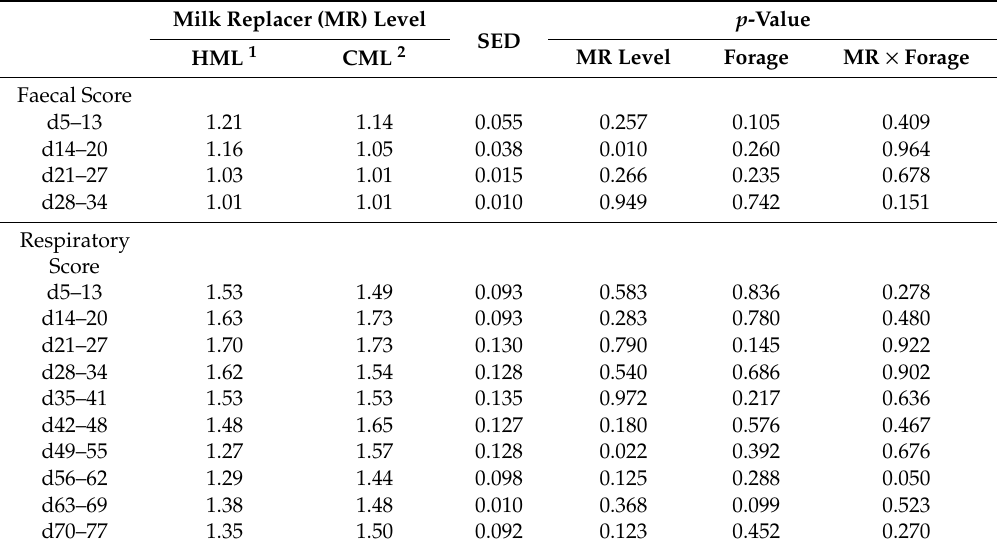
Table 4. Mean weekly faecal and respiratory scores of calves o ff ered high or conventional levels of milk